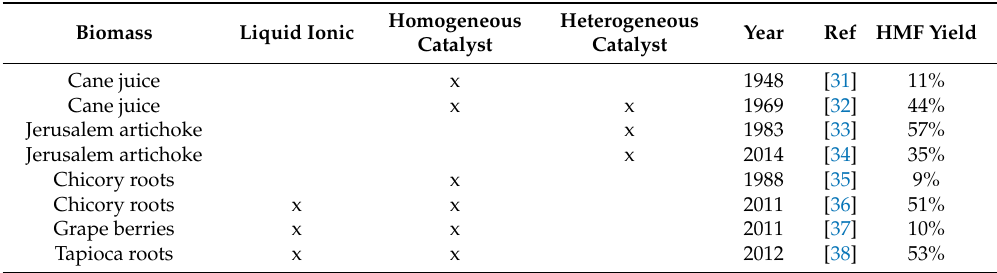
Table 1. HMF production from edible